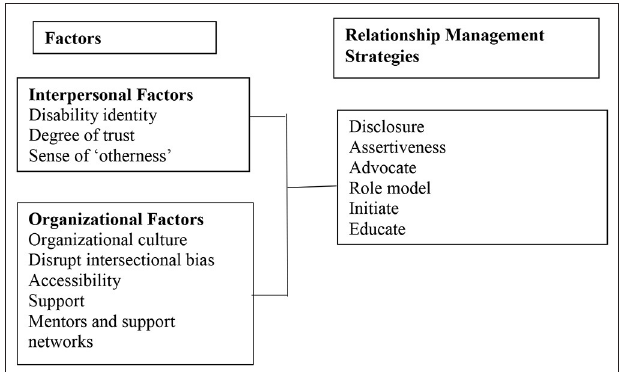
FIGURE 1 | Relationship management strategies adopted by women with